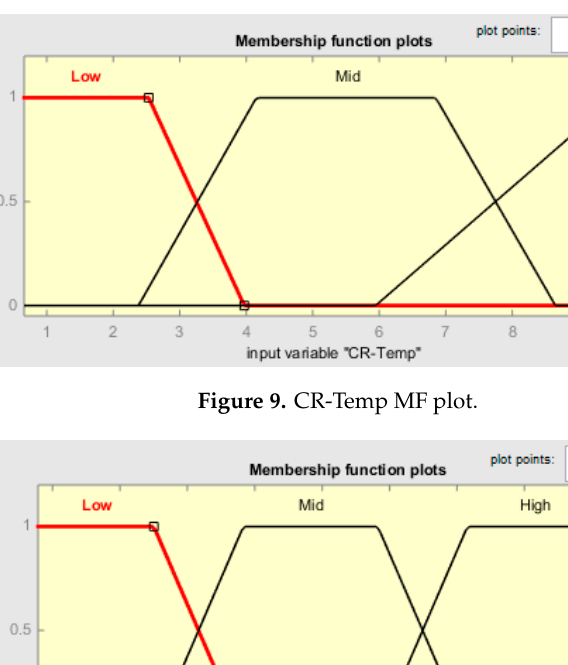
Figure 10. MF plot for CR-Humidity.